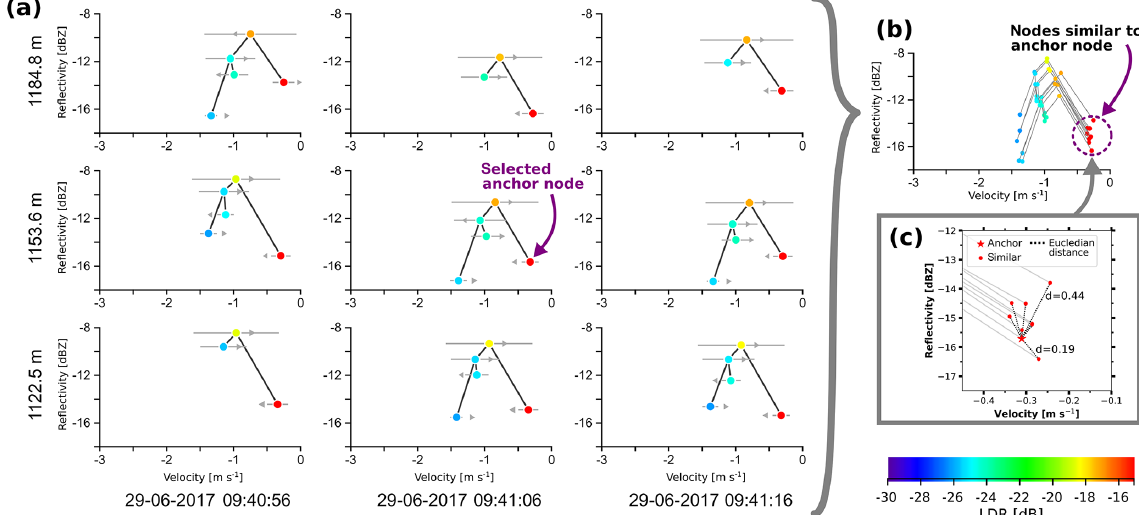
Figure 3. Illustration of the grouping algorithm for one anchor node. Single trees for a time–height slice of MIRA-35 observations are depicted in (a) with the selected anchor node marked by an arrow. The time–height cross section shown omits the outer trees of the 5 × 5 slice for clarity. The moments of each node are illustrated, as described in Fig. 2. In (b) , the trees are combined into the same v − Z illustration with a circle denoting the nodes that are identified as similar by the Euclidean distance criterion. The Euclidean distance d is depicted in inset (c) for all nodes with index